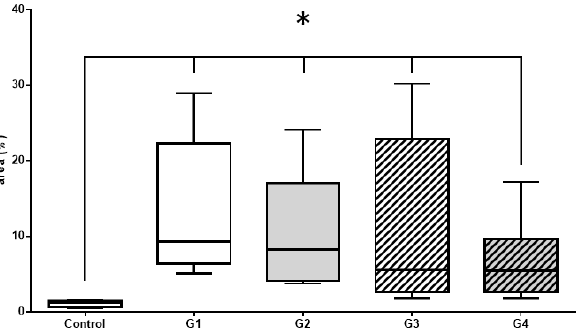
Figure 7. Immunohistochemistry—analysis of results immunomarked sections with VEGF by ana- lyzing the Kruskal–Wallis statistical test with Dunn’s posttest. There was no significant statistical difference between the treated groups, but there was a statistically significant difference between the treated groups and the control group, which did not receive any type of treatment.